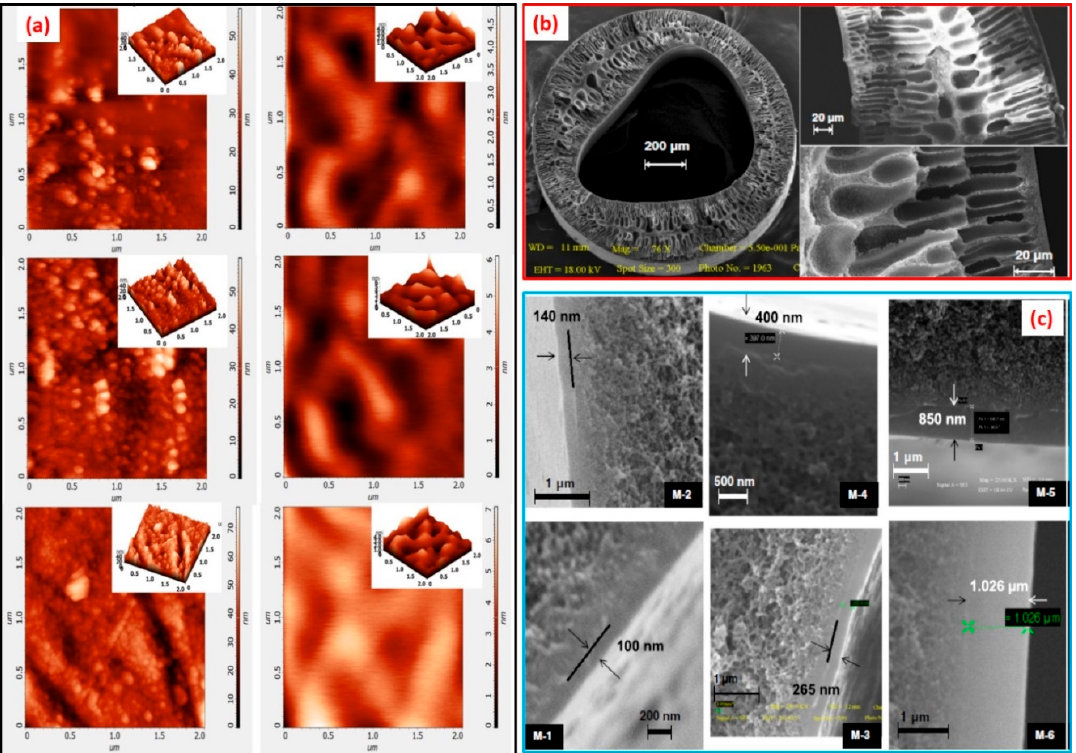
Figure 13. Cross-sectional SEM images of ( a ) hollow fiber support; ( b ) composite membranes; and ( c ) top surface AFM images of the composite membranes and (inset) 3D images of the respective samples. Reprinted with permission from [114]. Copyright 2015 Elsevier B.V.